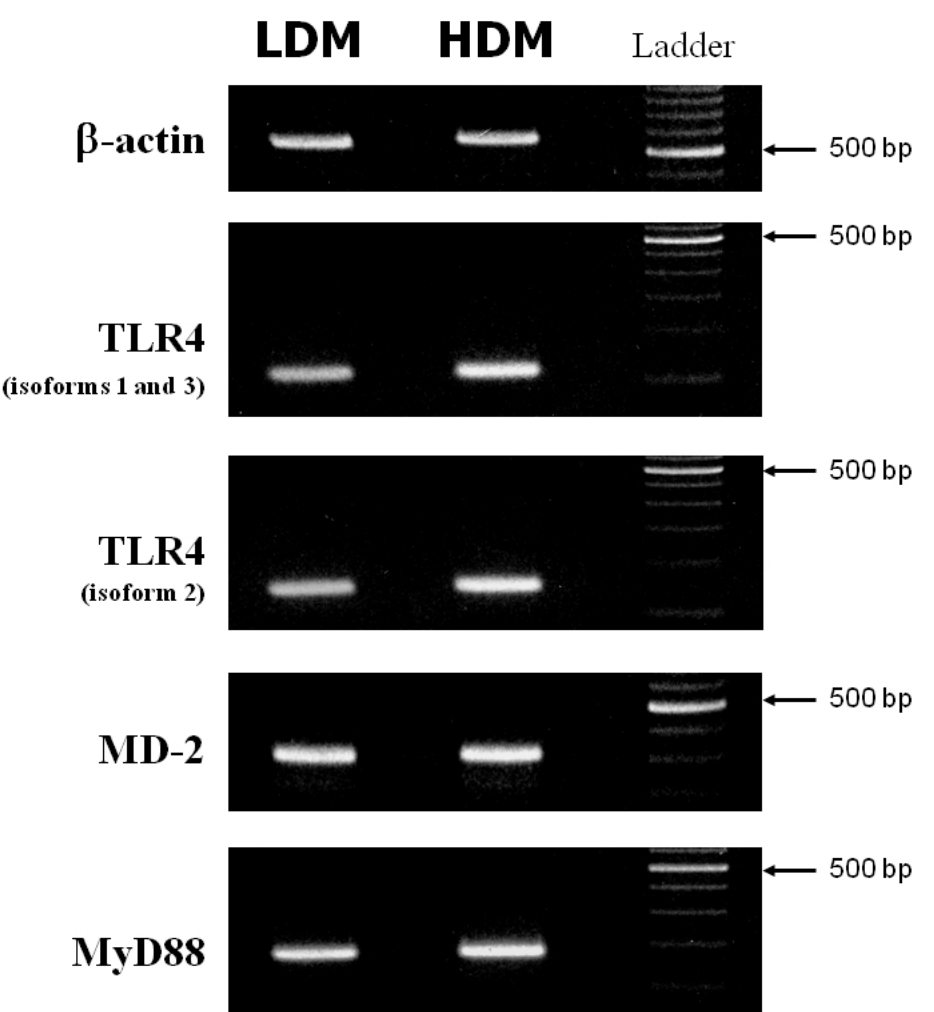
Figure 7. RT-PCR of TLR4, MD-2 and MyD88 from LDMs and HDMs. β -actin, TLR4 (isoforms 1 and 3 = second row; isoform 2 = third row), MD-2 and MyD88 specific RT-PCR amplification products from freshly isolated LDMs and HDMs. This figure shows one representative experiment of the three performed.